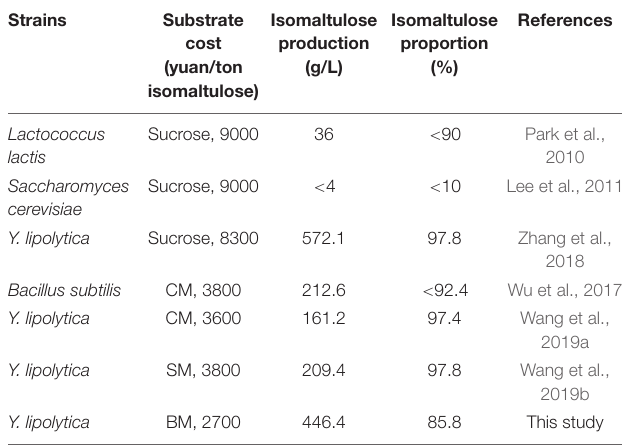
TABLE 1 | Comparison of the costs from different substrates for isomaltulose production by different engineered food-grade strains and the purity of isomaltulose.